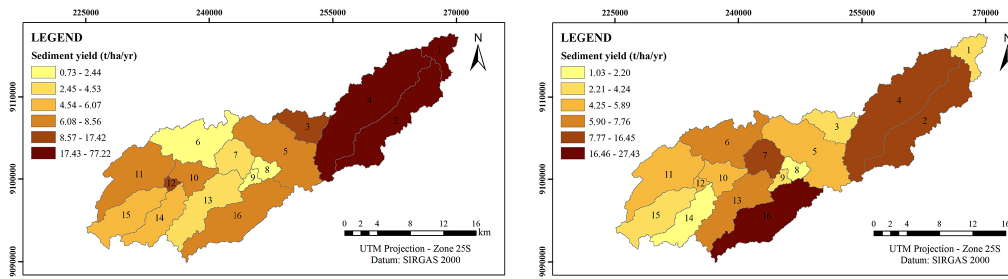
Figure 3. Simulated sediment yield in the Tapacurá River basin: (a) 1967–1974, and (b) 1995–2008.